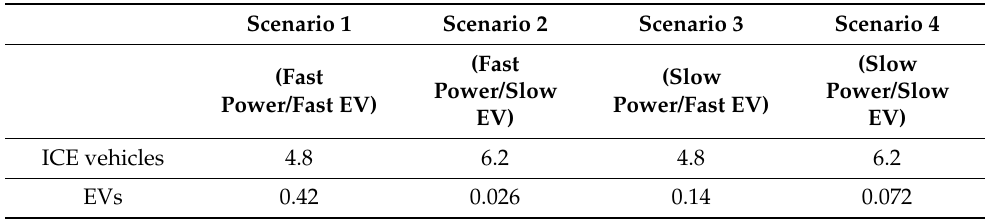
Table 3. Total cumulative passenger vehicle fossil fuel consumption from 2020 to 2045 on Oahu by Scenario, (based on faster and slower projections for both the renewable resources on the power grid, and for the rate of EV adoption, billion GGe).